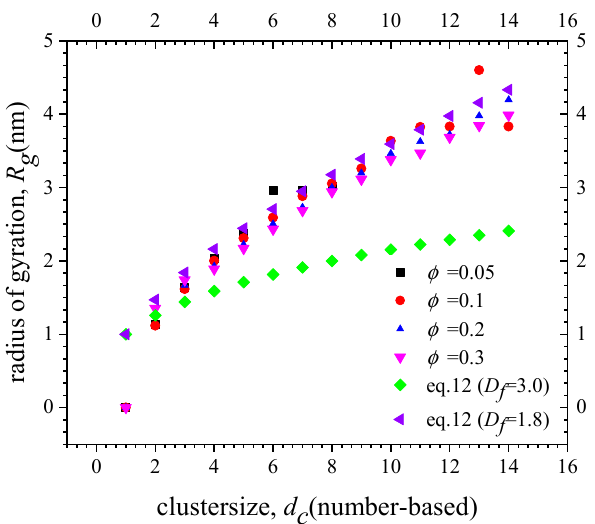
Figure 8. Agglomeration compactness under different initial particle sizes.